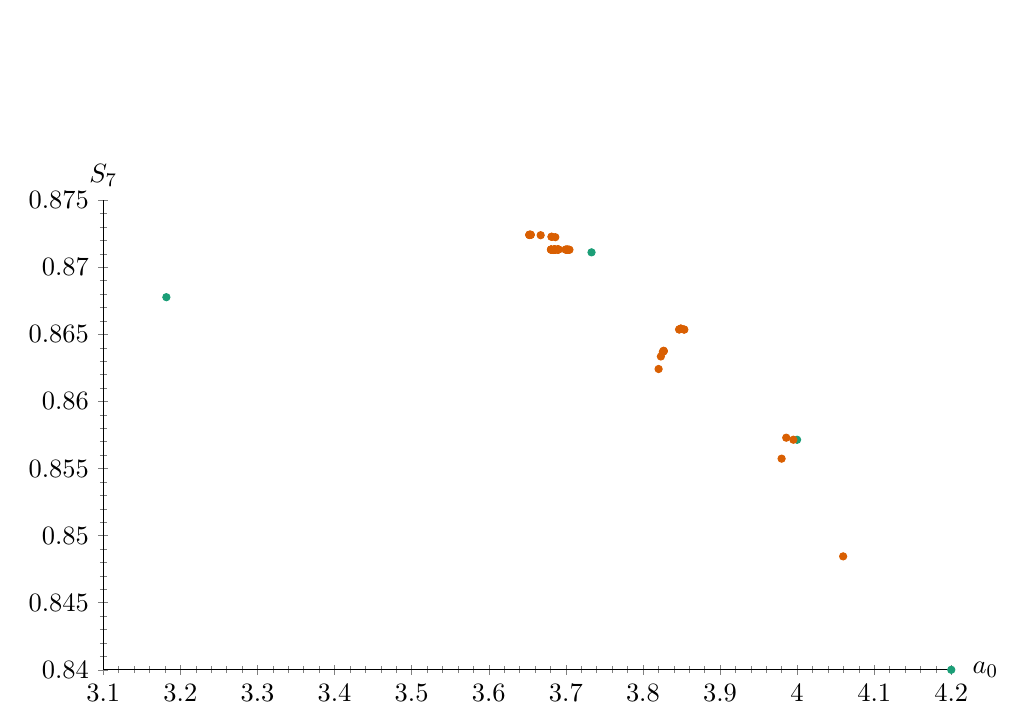
Figure 3. Fully-interacting fixed points for N = 6 . The leftmost point corresponds to T 6+ and the rightmost to O(6) .